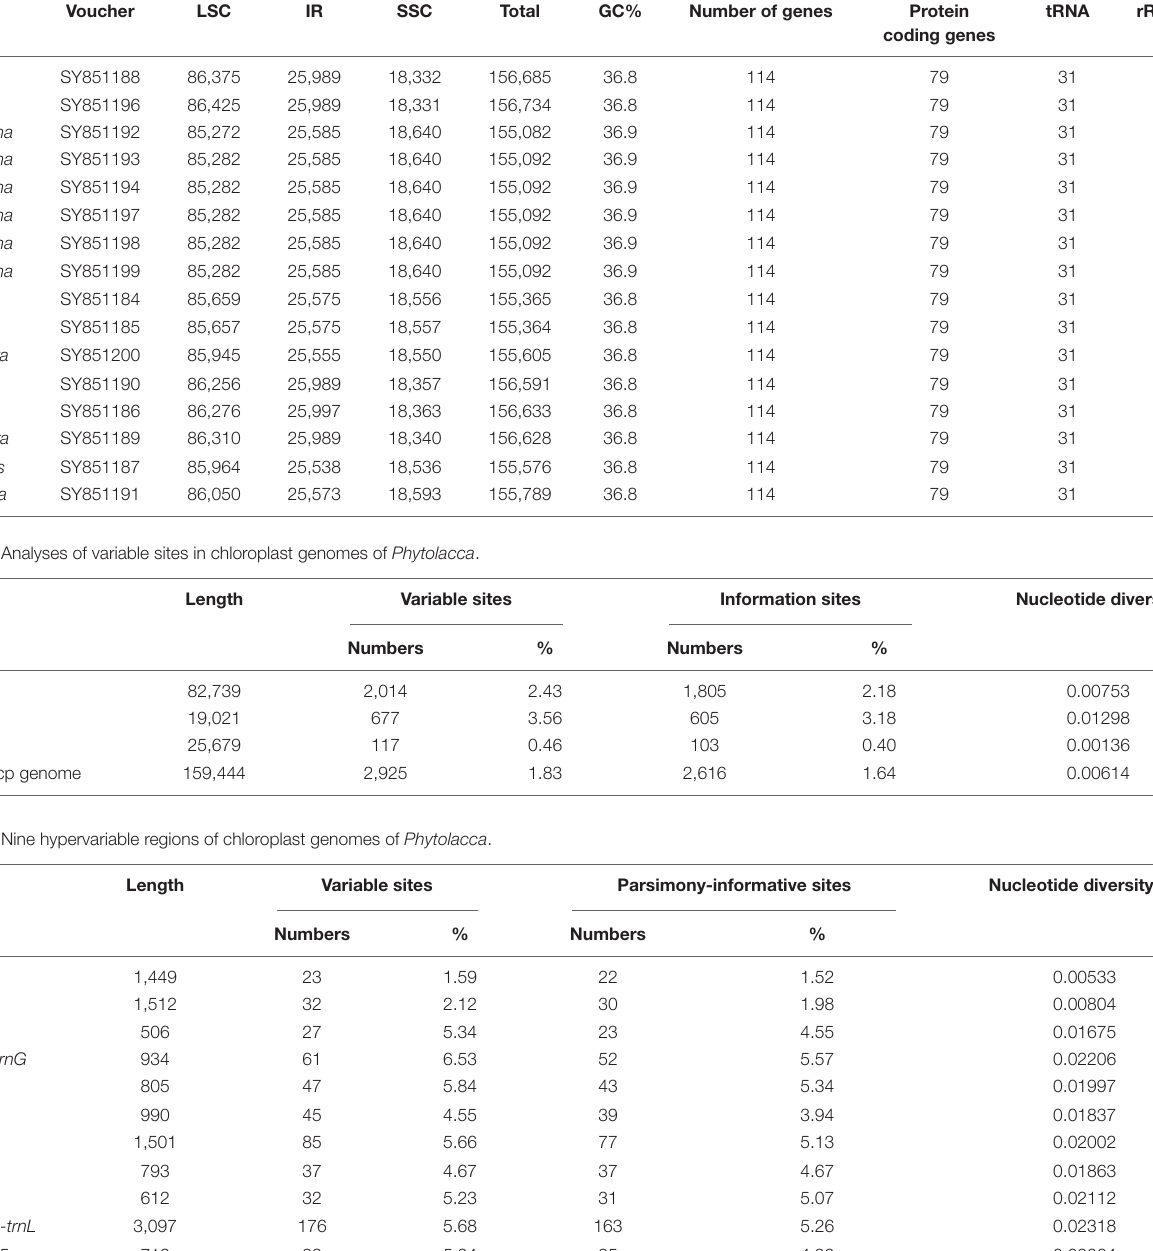
TABLE 1 | Chloroplast genome features of Phytolacca chloroplast genomes. Species